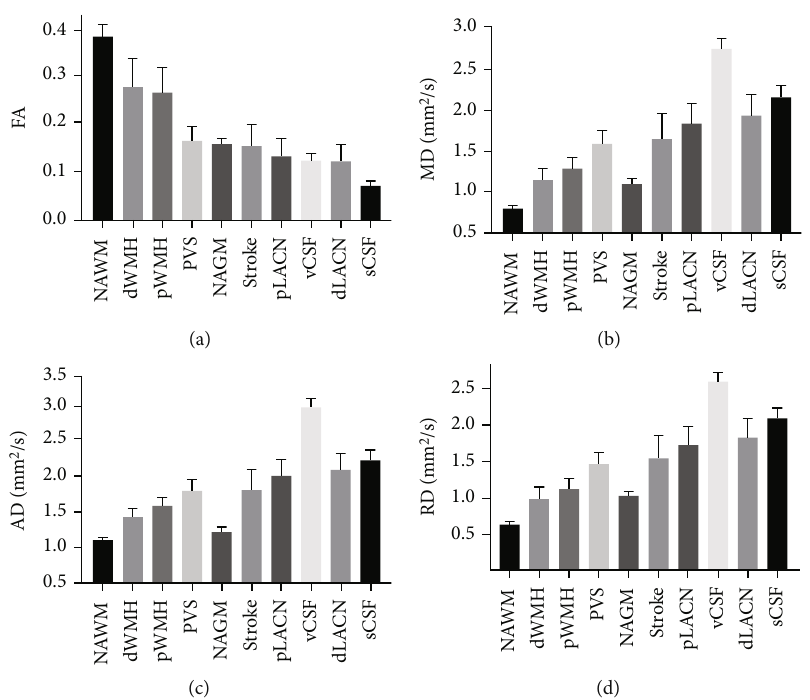
Figure 3: The mean FA (a), MD (b), AD (c), and RD (d) values measured by the DTI processing pipeline are provided for all segmented tissues. Error bars represent the coe ffi cient of variation.